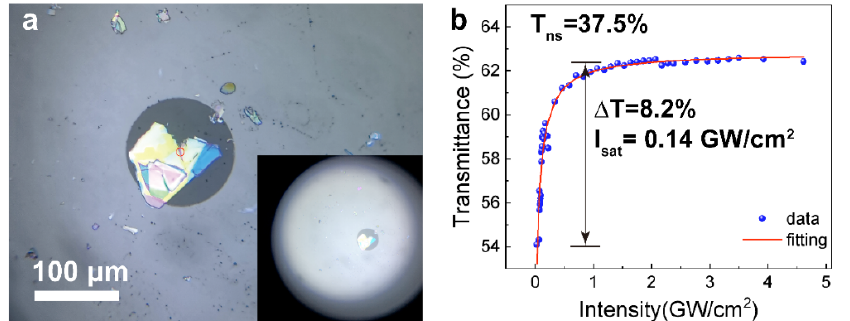
Figure 3. Characteristic of the GaS ‐ SAs. ( a ) The optical microscope digital image of GaS nanosheets attached on the fiber end face. Inset: The panorama of the surface of the optical fiber connector. The bright spots near the center are GaS nanosheets. ( b ) Nonlinear transmission of the GaS ‐ SA.